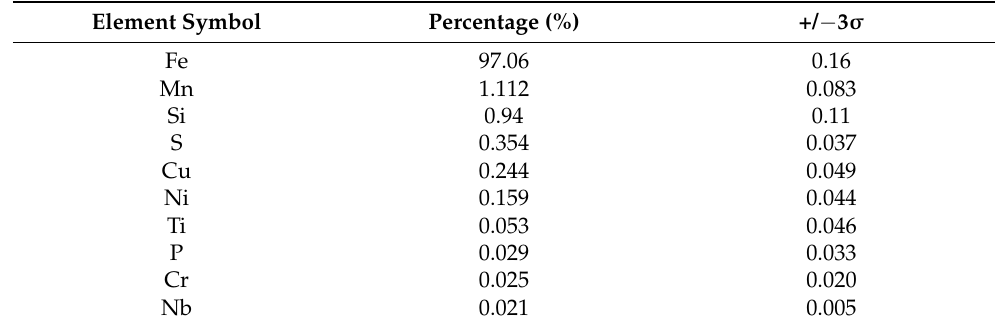
Table 1. Elemental composition of sample no. 4 obtained using X-ray fluorescence spectrometer.